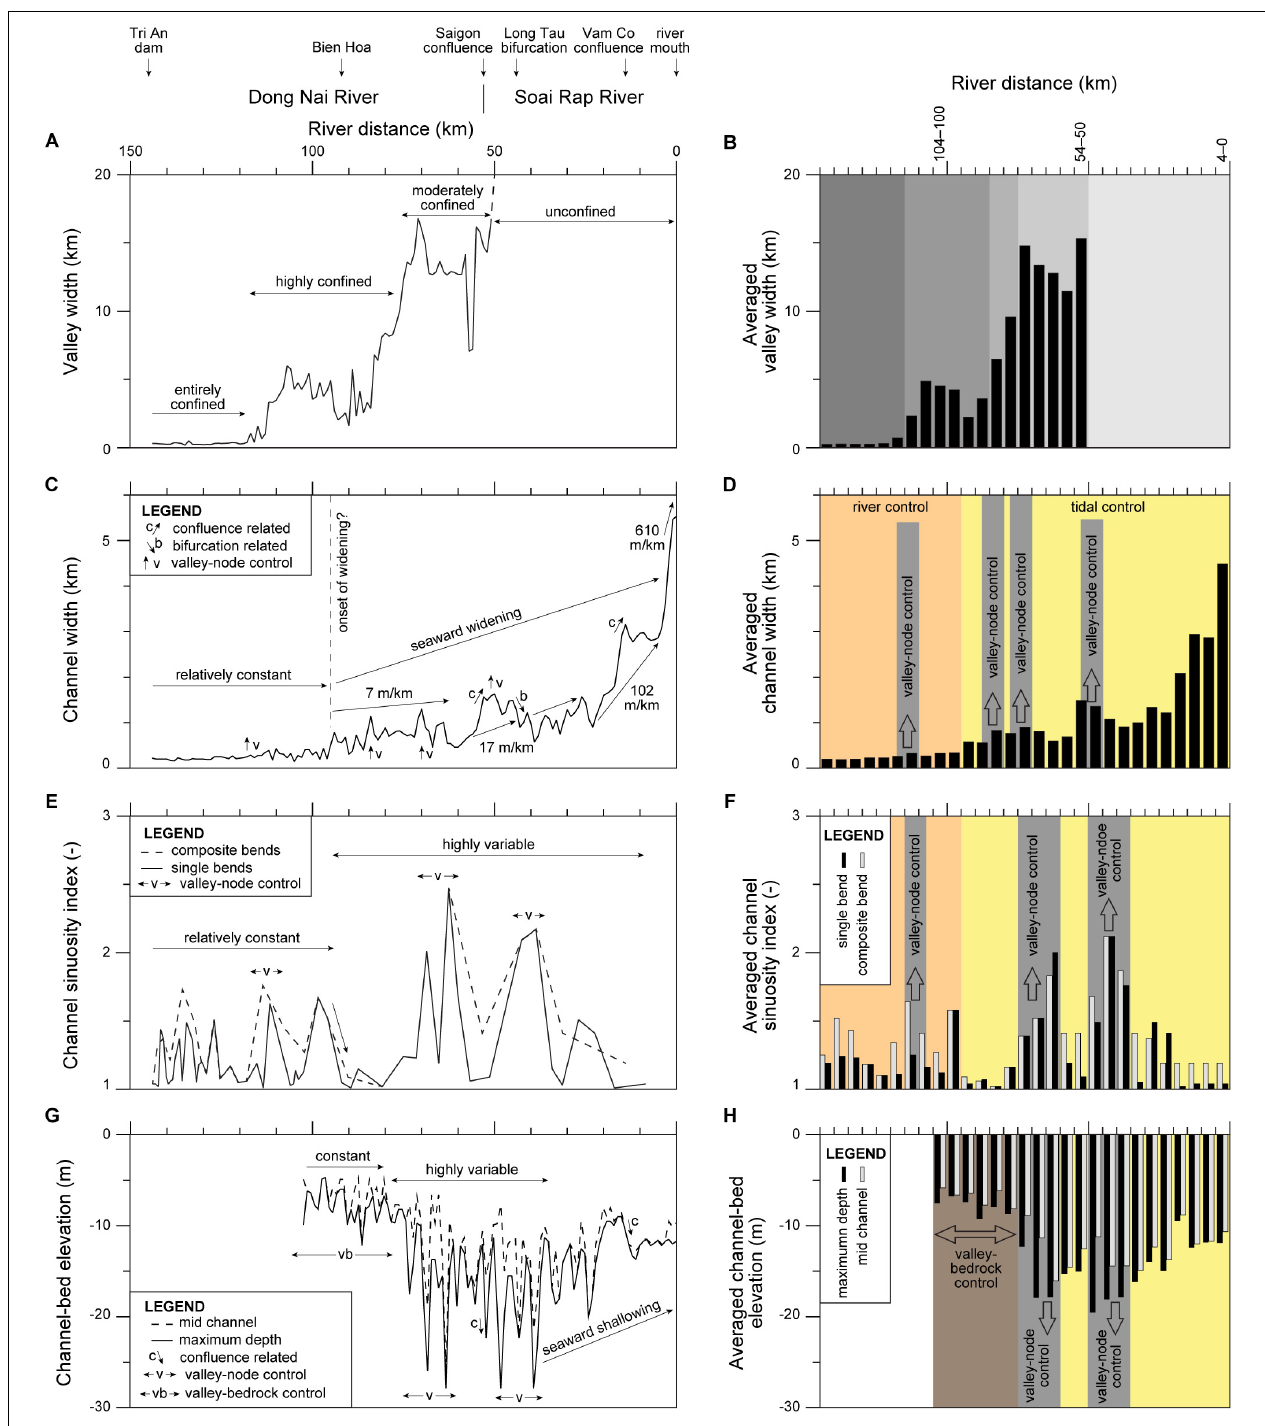
FIGURE 4 | Measured and averaged valley width (A,B) , channel width (C,D) , channel sinuosity index (E,F) , and channel-bed elevation (G,H) along the Ð`ông Nai–Soài Ra.p